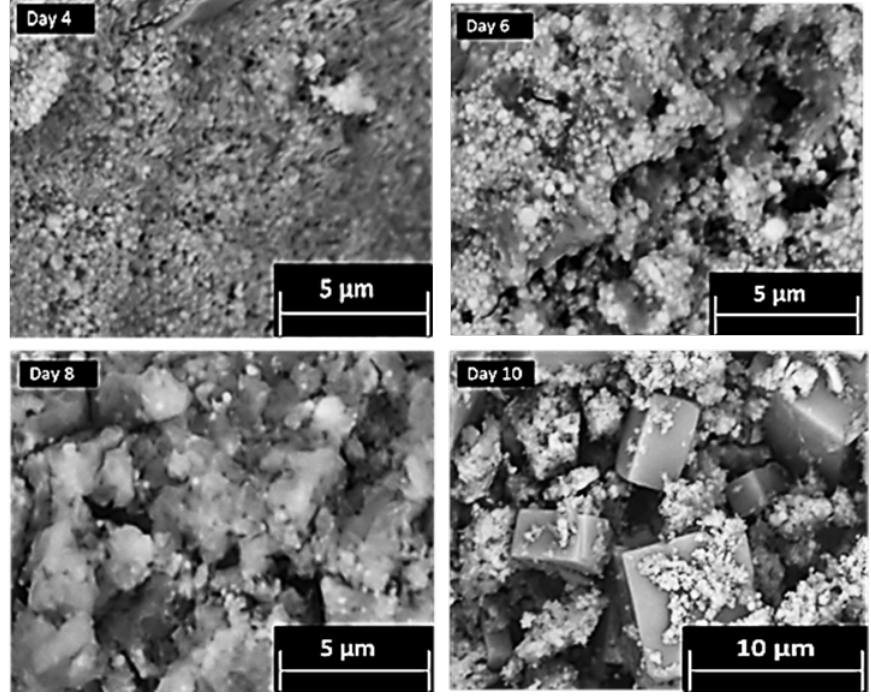
Figure 4. Scanning electron micrographs taken at various times during the tracking of zirconium molybdate (ZM-a) synthesis from a caesium phosphomolybdate (CPM) precursor over 10 days.